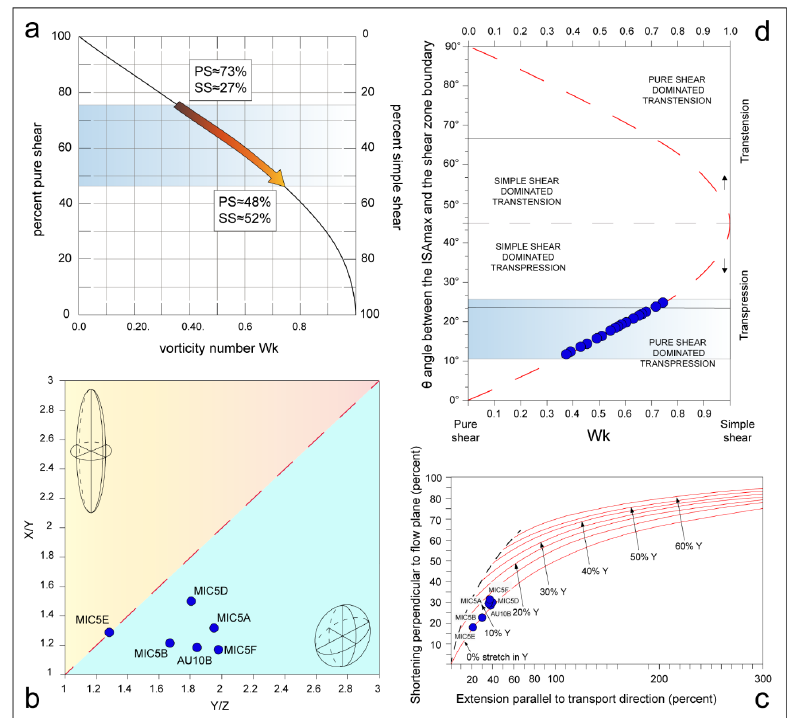
Figure 7. ( a ) Percentage of pure shear (PS) and simple shear (SS) in relation to the calculated maximum and minimum Wk values; ( b ) Flinn diagram showing how the analyzed samples (blue dots) fall mostly in the apparent flattening field; ( c ) curves representing the shortening perpendicular to flow plane versus the extension in the transport direction for general flattening with 0–60% stretch along the Y axis of the finite strain ellipsoid (modified from Law, 2010 [80]); ( d ) diagram showing the relationship between the orientation of the maximum instantaneous stretching axis (ISAmax) with respect to the shear zone boundary (angle θ ) related to the kinematic vorticity number Wk (modified after Fossen and Tifo ff , 1993 [75]). Samples mostly fall in the field of pure shear-dominated